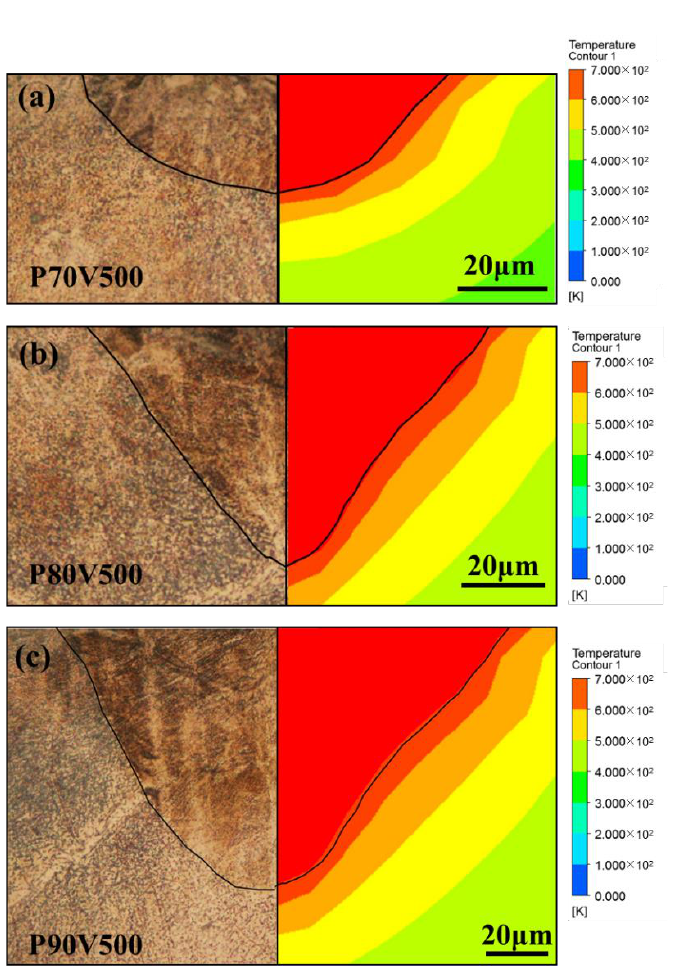
Figure 4. Penetration shape and temperature contour of the Zn plates, as obtained by the experiment and calculation, for laser powers of ( a ) 70 W, ( b ) 80 W, and ( c ) 90 W.